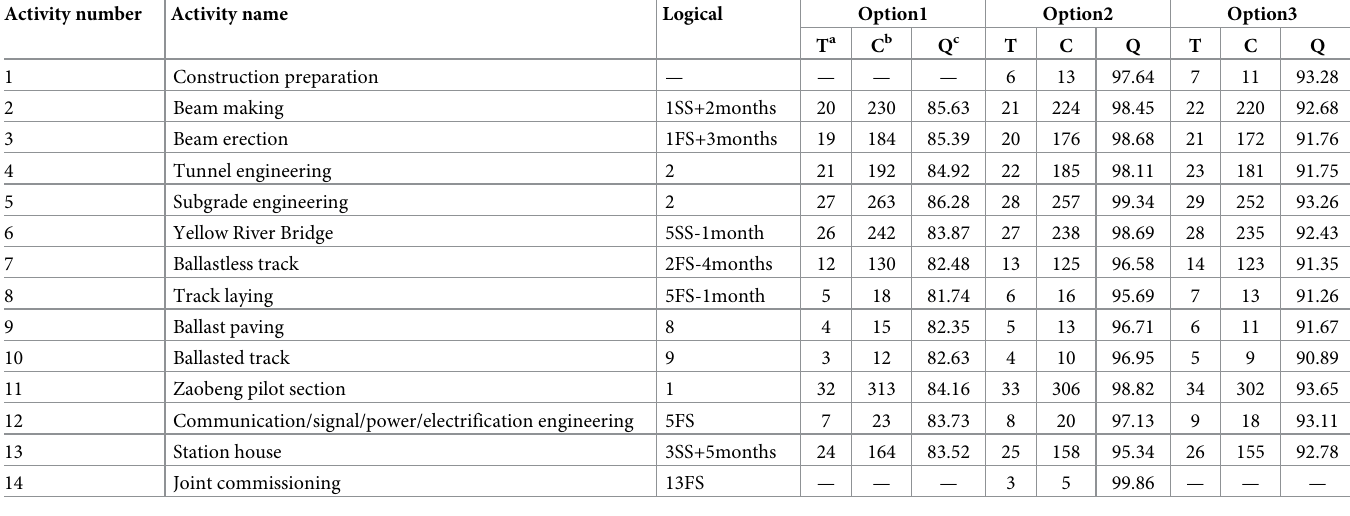
Table 3. Construction activities and corresponding parameters of Beijing-Shanghai high speed railway. Activity